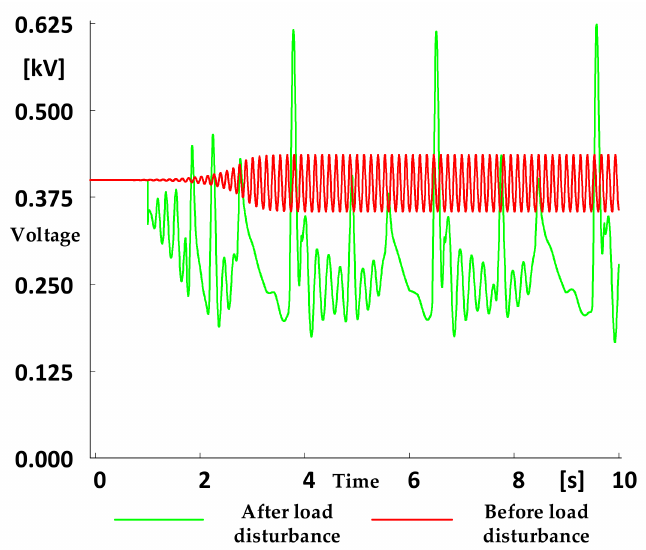
Figure 8. Voltage waveform with or without load disturbance.